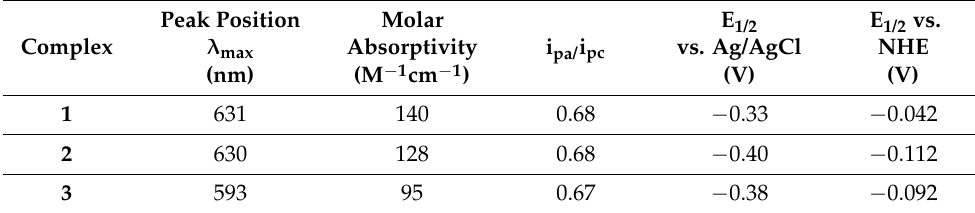
Figure 3. Optical spectra of complexes 1 (black line), 2 (red line), and 3 (blue line) in water using a quartz cuvette with a 1 cm path length. All complexes are dissolved in water to give a 4 mM concentration. Table 1. Optical and electrochemical parameters for 1 – 3